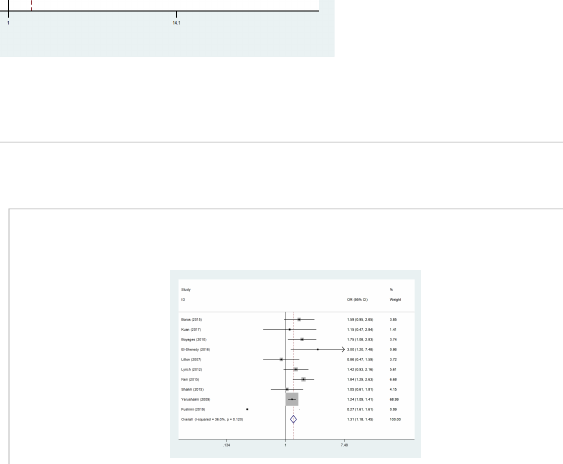
FIGURE 5 Forest plot of RFS comparing MMBC and UFBC.